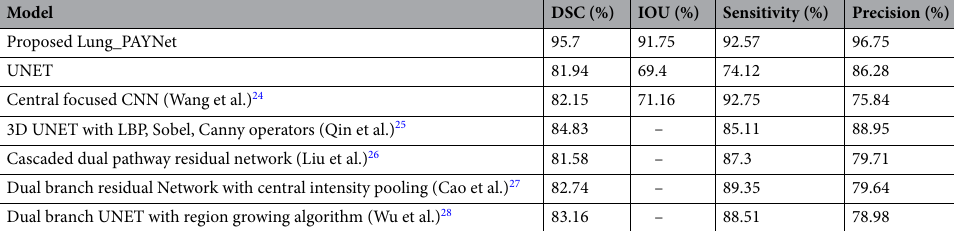
Table 3. Comparison of the Proposed Architectures with State-of-the-Art Segmentation Techniques.